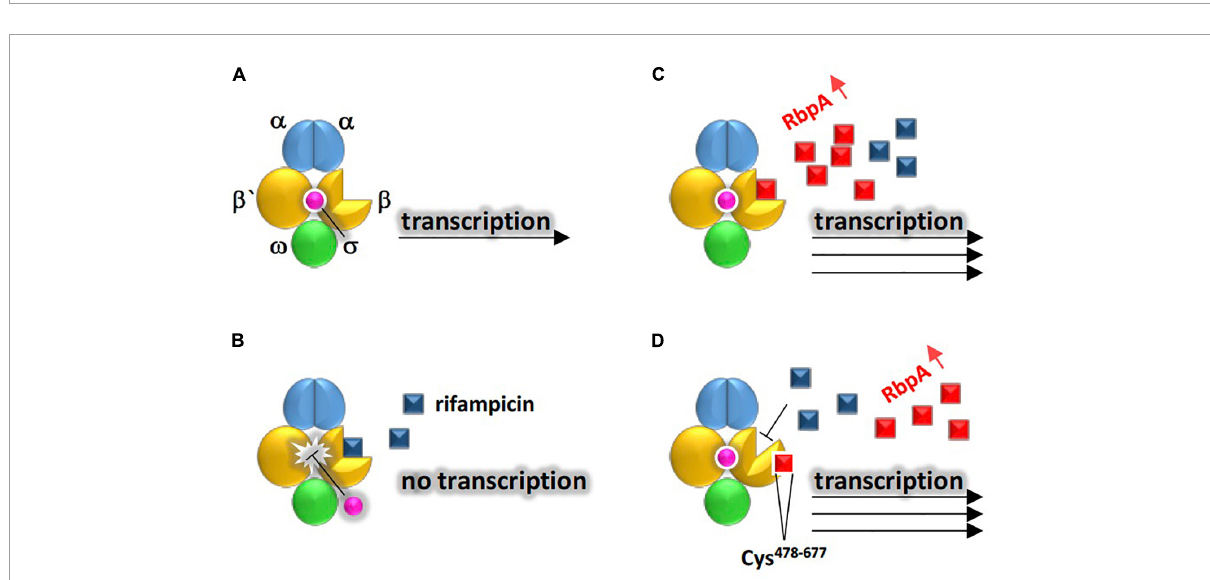
FIGURE10 Demonstration of the two suggested resistance mechanisms existing in rhizobiome of M. oleifera against rifampicin conferred by RbpA to allow RNA polymerase (RNAP) properly conduct transcription of virulence genes. Structure of RNAP is made of the holoenzyme (representing the catalytic core that is made of five subunits of ααββ ’ ω ) and a promoter-specific σ factor (for promoter recognition and conduction of transcription on the DNA antisense strand) located between residues Cys 478 and Cys 677 of β subunit. (A) No rifampicin, (B) presence of rifampicin and absence of RbpA, (C) resistance mechanism of antibiotic target protection where RbpA occupies rifampicin target site in β subunit of RNAP to make the binding site inaccessible to the antibiotic (D) resistance mechanism of alteration of antibiotic target where RbpA causes allosteric changes in the rifampicin binding site in